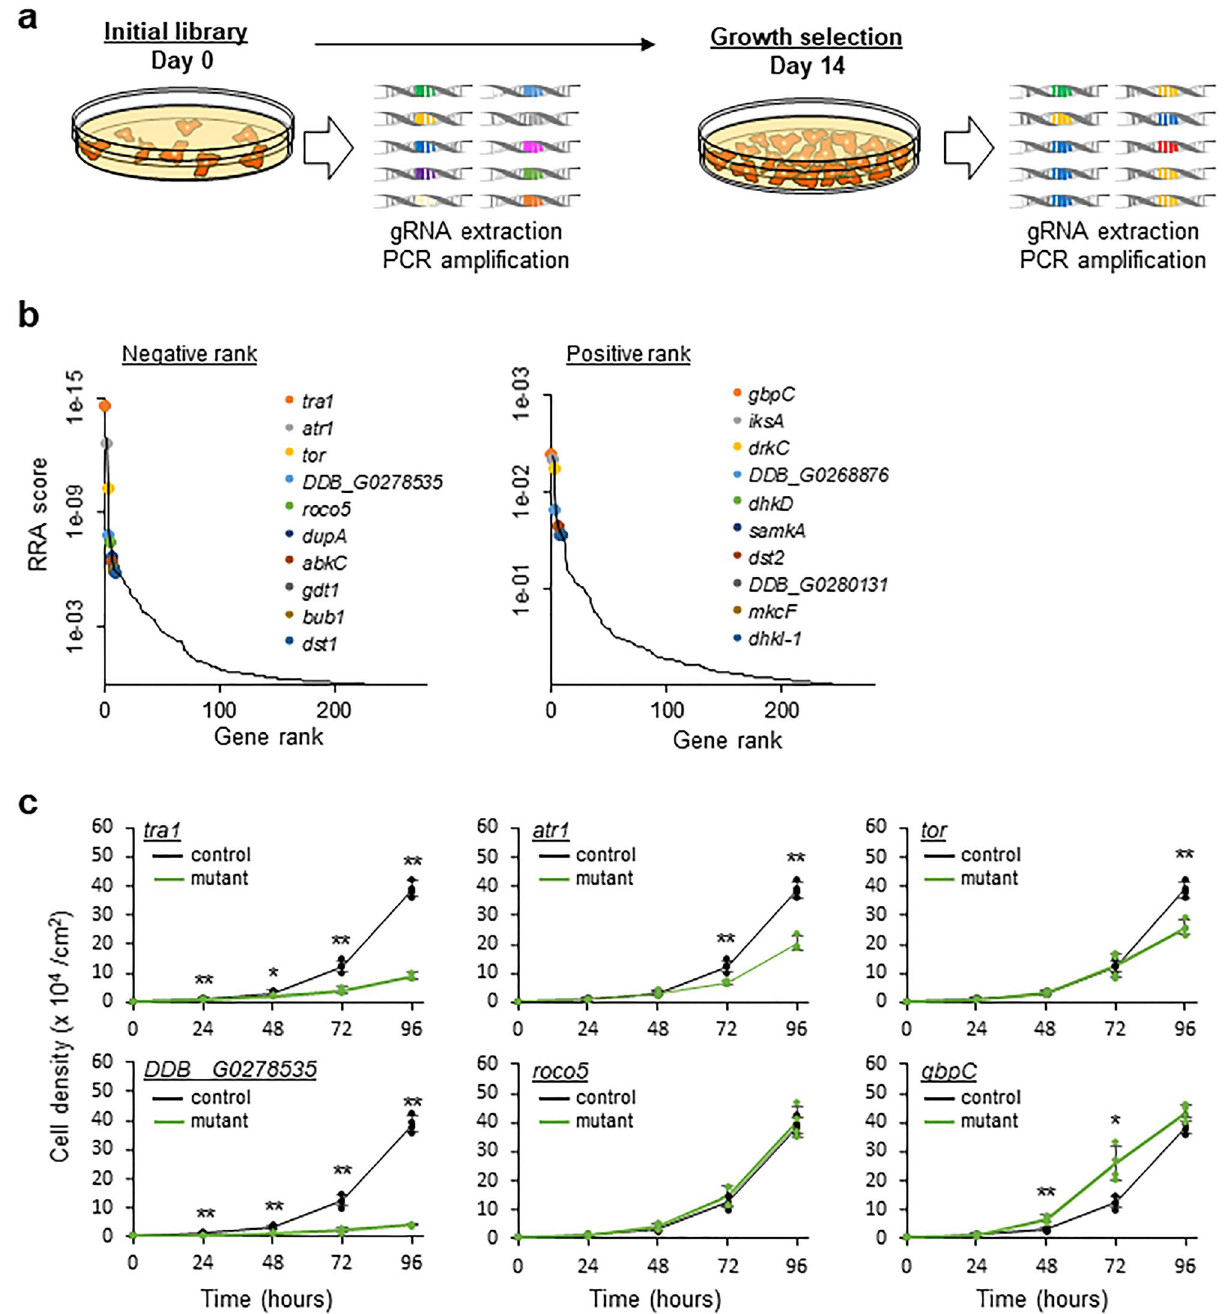
Figure 3. Genetic screening using the kinase sgRNA library and genetic validation of candidate genes regulating cell growth. ( a ) Schematic overview of genetic screening for cell growth with the kinase gRNA library. ( b ) Candidate genes identified by CRISPR-based screening. Data analysis using MAGeCK revealed under- (left) and over-represented (right) gRNAs and ranked the corresponding genes with RRA scores. Low RRA scores indicate stronger enrichment. ( c ) Growth curves of recreated CRISPR mutants. Data points represent the mean ± SD of 3–4 biological repeats and individual data points are shown. Samples were compared with Welch t -test; * p < 0.05; ** p <